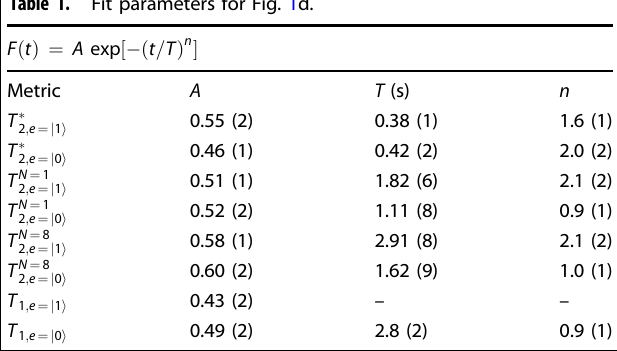
Table 1. Fit parameters for Fig. 1d.